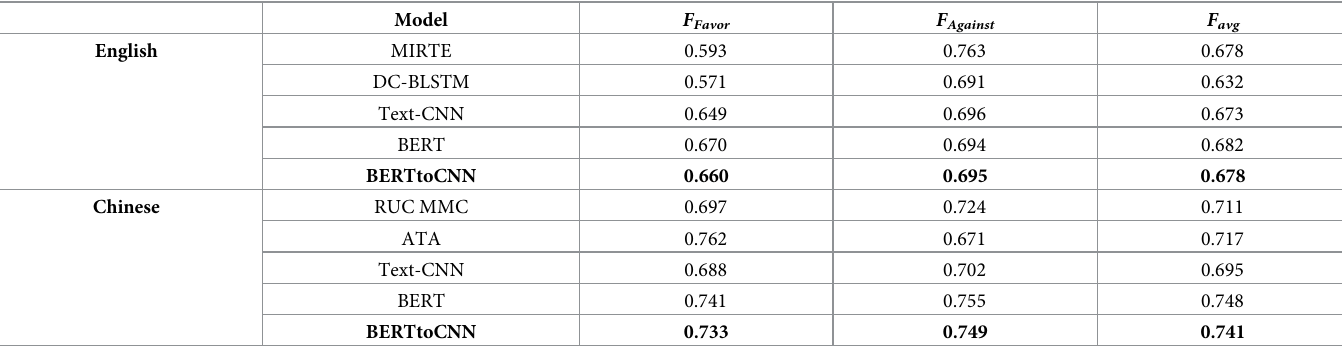
Table 4. The performance of BERTtoCNN compared with the baseline methods.